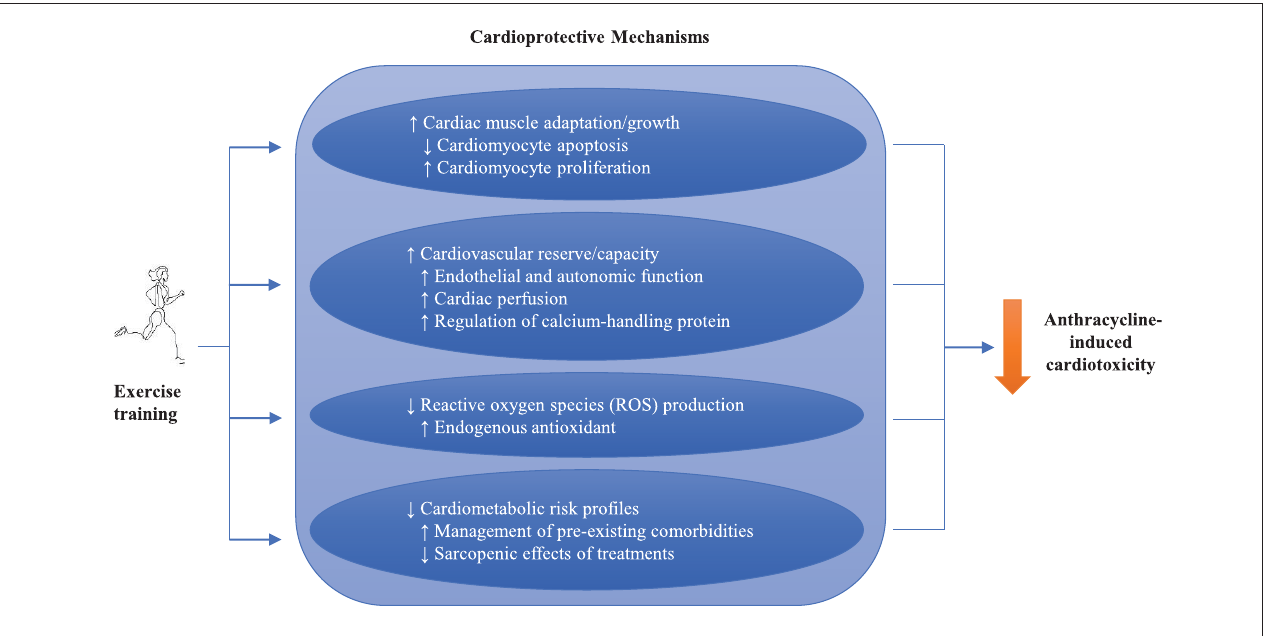
FIGURE 2 | Potential mechanisms of exercise training on anthracycline-induced